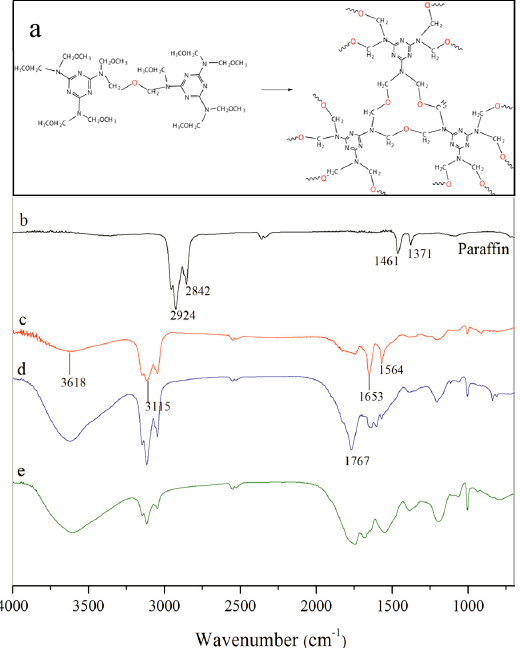
Figure 5. Chemical structural of microPCMs samples, ( a ) chemical formula of MMF prepolymer crosslinking process; FT-IR curves of microPCMs samples: ( b ) pure paraffin; ( c ) MG-2; ( d ) MG-4, and ( e ) MG-6.